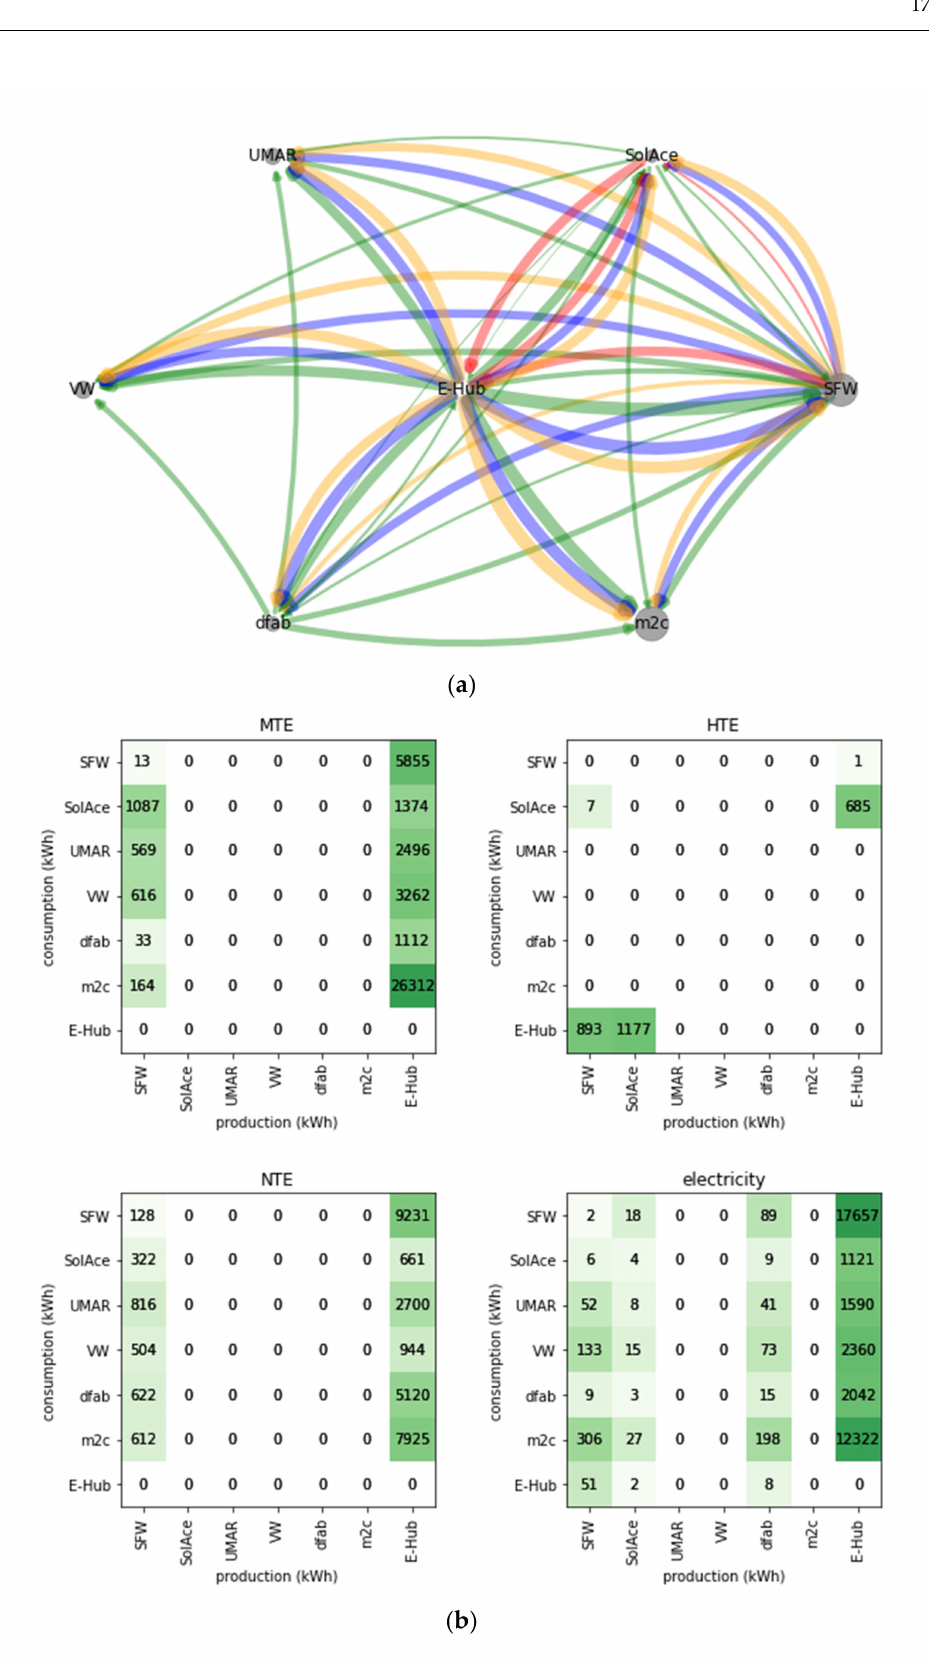
Figure 9. Energy exchange diagram between units at NEST ( a ) and relative association matrixes ( b ). In the diagram, flow thickness is proportional to the logarithm of the energy amount, while the node size is proportional to the annual total energy demand of the